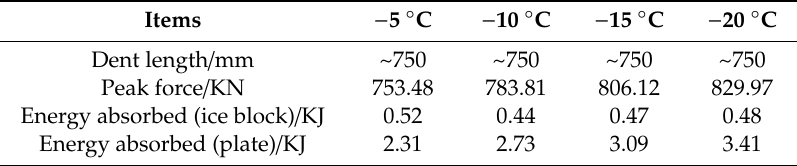
Table 3. Variation in drop parameters at different temperatures.